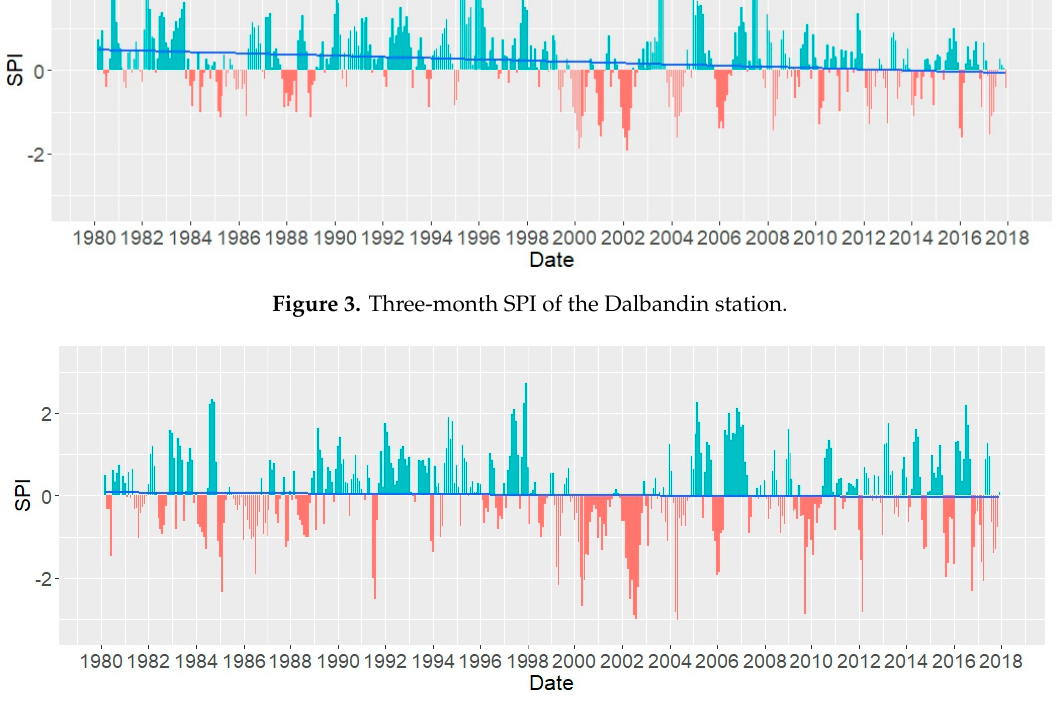
Figure 4. Three-month SPI of the Barkhan station.